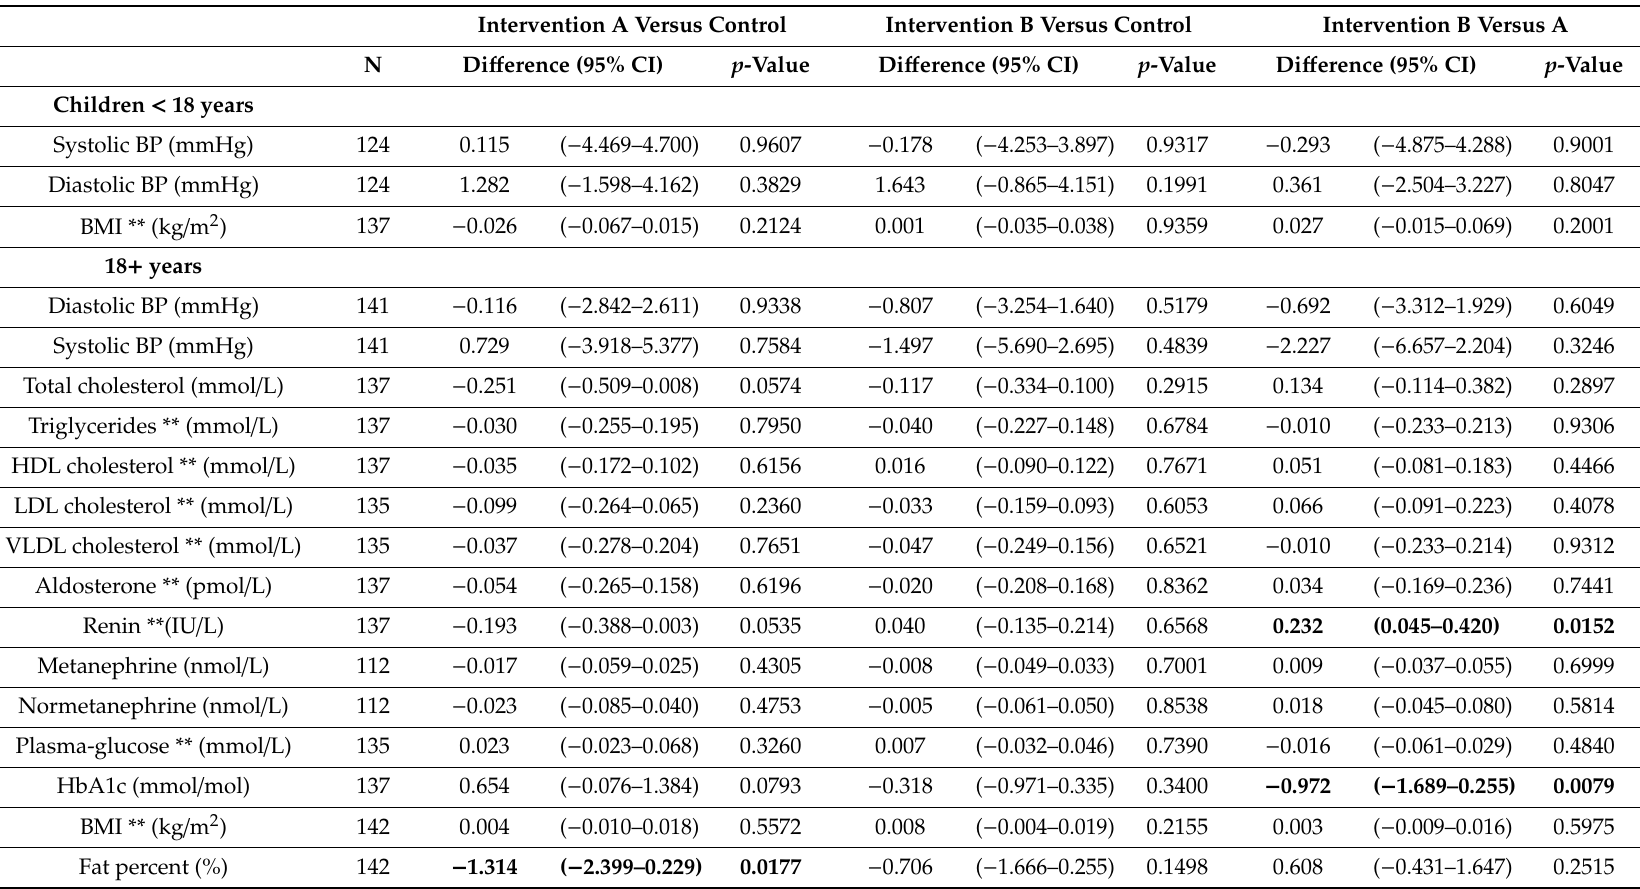
Table 3. Between group di ff erences and 95% confidence interval for cardiovascular risk factors (multiple